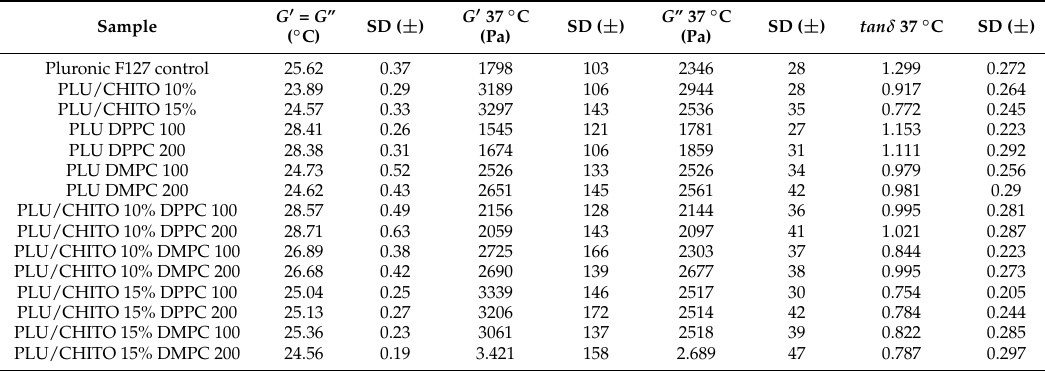
Table 1. Characterization of viscoelastic parameters of hydrogels.